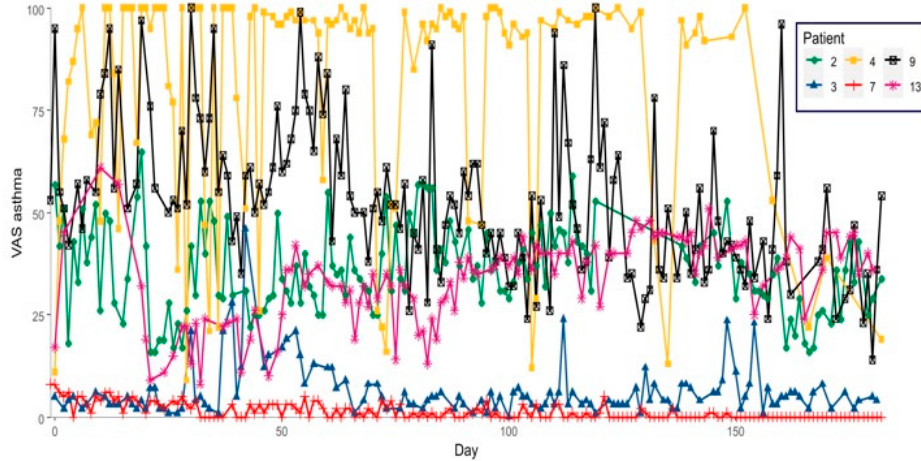
Figure 2. Trends of VAS asthma for patients with adherence of > 50%.